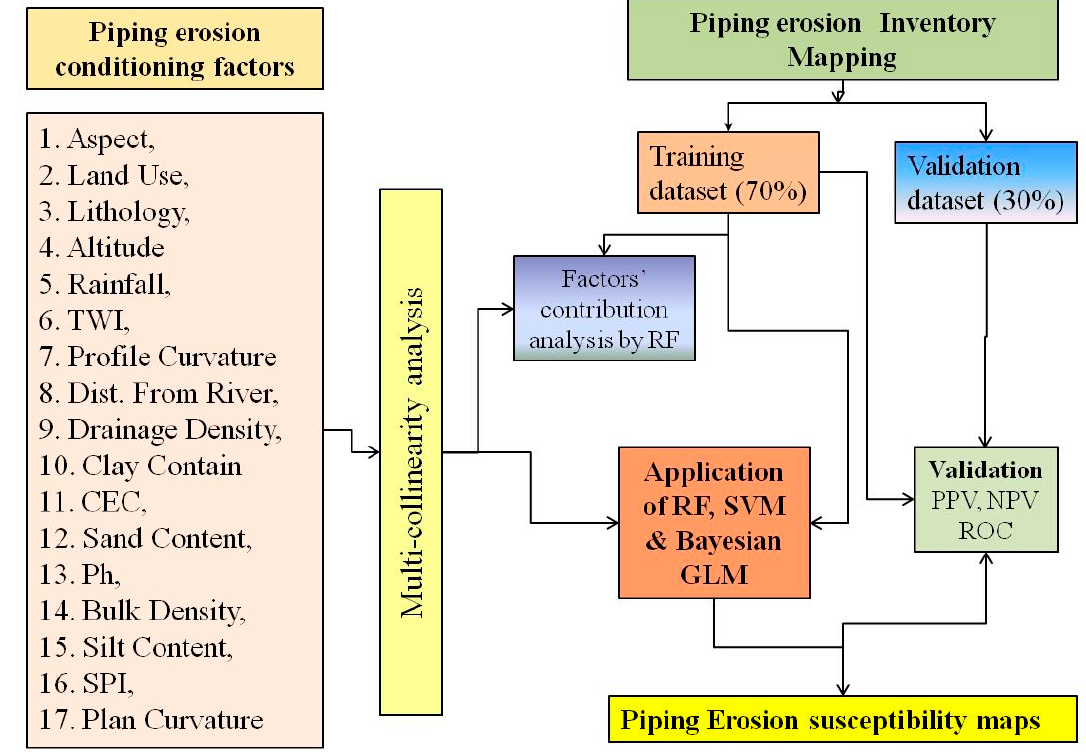
Figure 3. Methodological flow chart: topographic position index (TWI), cation exchange capacity (CEC), stream power index (SPI), precision predictive value (PPV), negative predictive value (NPV), receiver operating characteristic (ROC)